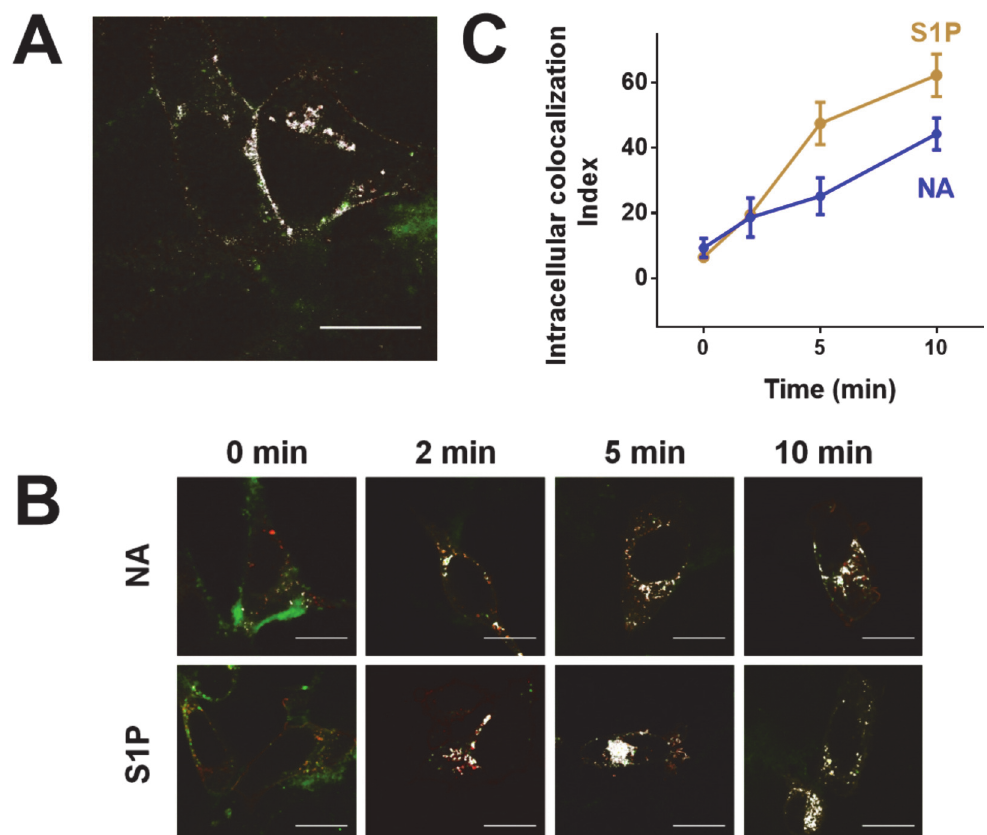
Fig 3. DsRed-tagged α 1B-adrenergic receptor and membrane-directed EGFP-tagged β -arrestin 2 colocalization. Panel A: Representative image of cells expressing DsRed-tagged human α 1B-adrenergic receptors and membrane-directed EGFP-tagged β -arrestin 2; colocalization is indicated in white. Panel B: Cells were incubated for the times indicated in the presence of 10 μ M noradrenaline (NA) or 1 μ M sphingosine 1-phosphate (S1P) and images were obtained. Plasma membrane fluorescence was deleted and intracellular colocalization is indicated in white. Panel C: Images obtained as indicated in Panel B were analyzed for intracellular colocalization of adrenergic receptors and β -arrestin. Plotted are the means and vertical lines representing the S.E.M. of 3 – 4 experiments using different cell preparations and 4 – 5 images were obtained and analyzed, from each condition. Scale bars: 15 μ m.